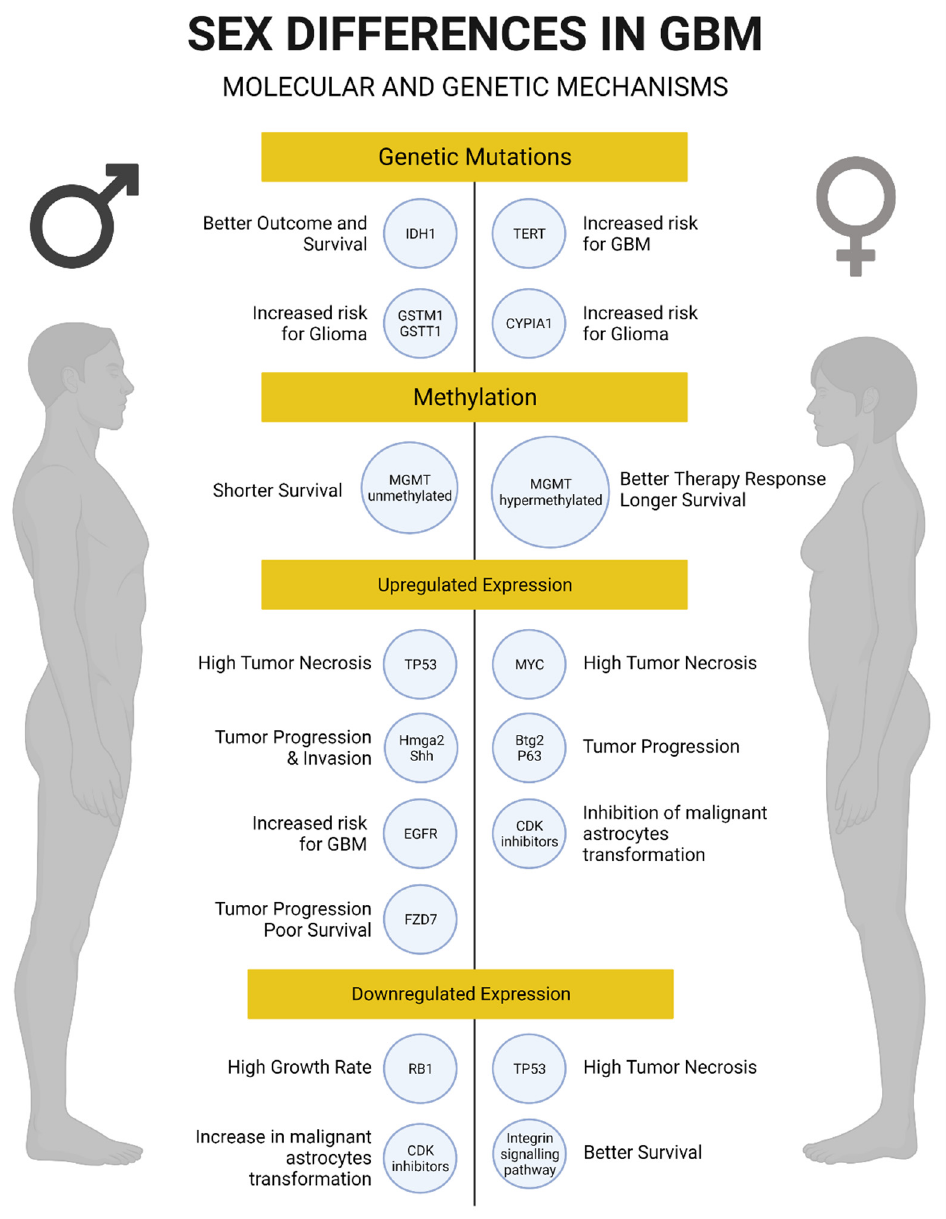
Figure 2. Summary of genetic and molecular mechanisms associated with glioblastoma in men and women. Created with BioRender.com.